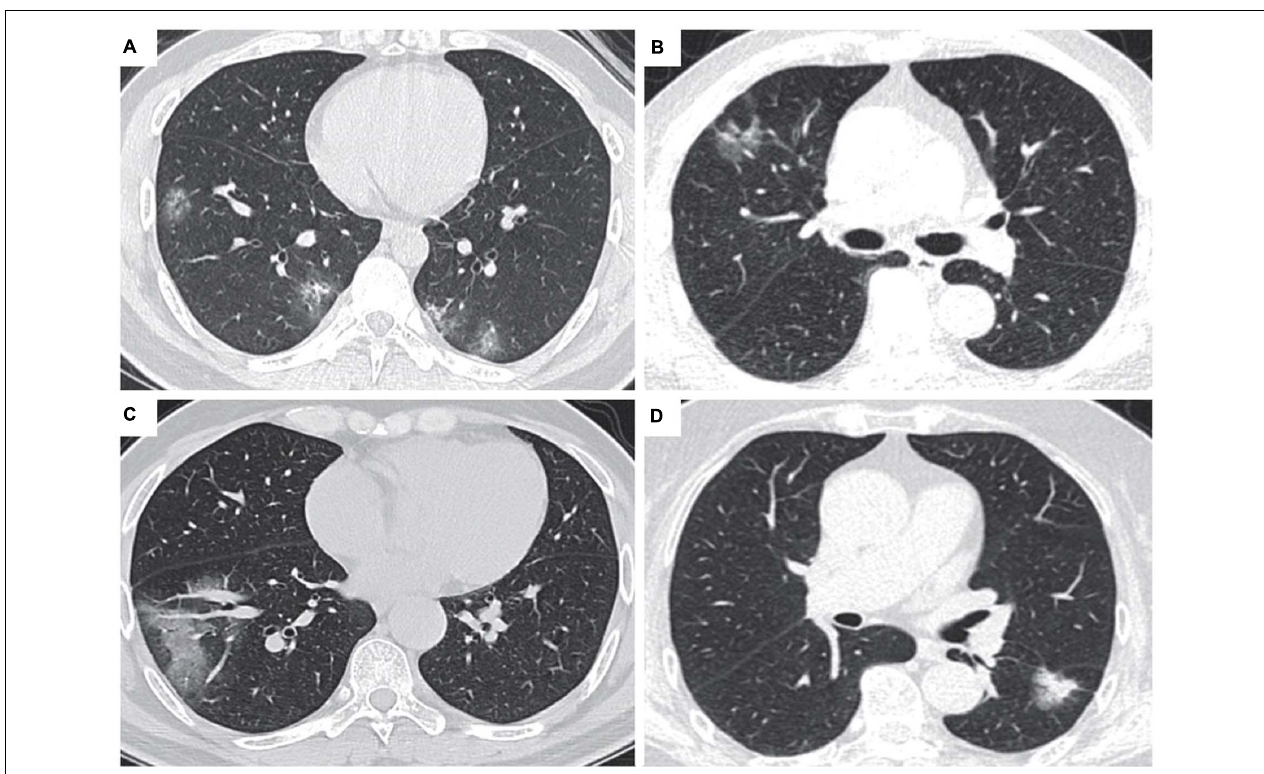
FIGURE 1 | CT images of lung cancer patients and COVID-19 (Transl Lung Cancer Res.2020 Aug;9(4):1516-1527.doi: 10.21037/tlcr-20-892). (A) CT scan of a patient diagnosed with COVID-19: The lesion is GGO, and there is no sign of pleural retraction or vascular convergence. (B) CT scan of a patient diagnosed with lung cancer, with pleural retraction and cystic change. (C) CT scan of a patient diagnosed with COVID-19, the lesion showed patchy turbidity, irregular shape, and no pleural retraction. (D) CT scan of a patient diagnosed with lung cancer, with pleural retraction, lobulated sign, and spiculate